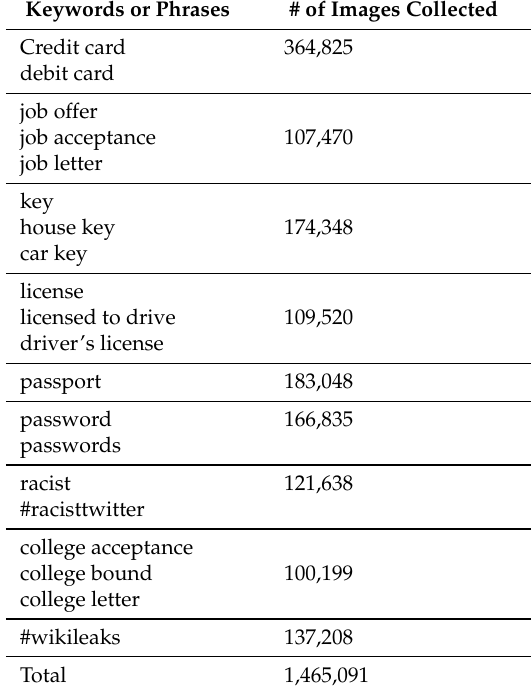
Table 12. Results of keyword crawling on Twitter. Keywords or